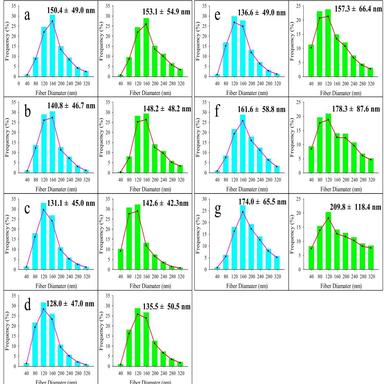
Fiber diameter distributions of PPI/PUL NFs with various glucose content before (left) and after (right) cross-linking: a-0%, b-0.5%, c-1.0%, d-1.5%, e-2.0%, f)− 2.5%, g-3.0%.